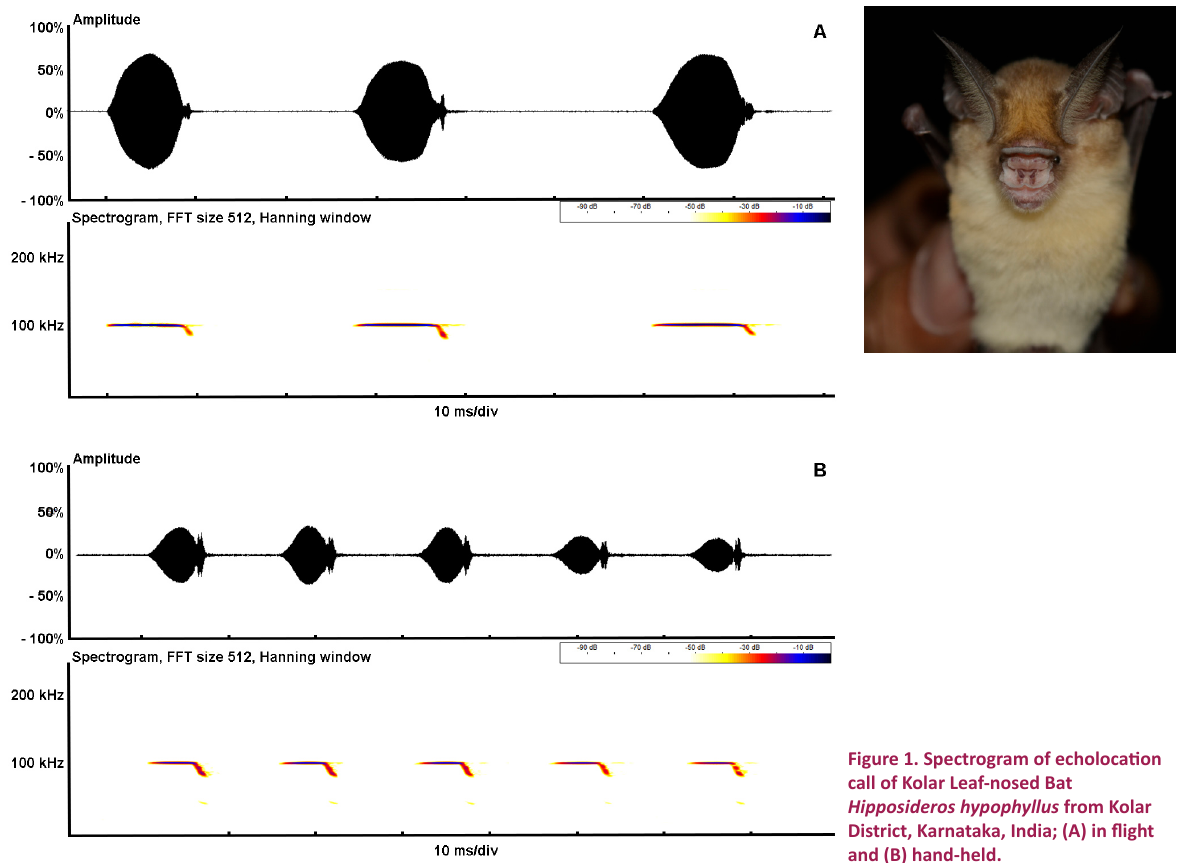
Figure 1. Spectrogram of echolocation call of Kolar Leaf-nosed Bat Hipposideros hypophyllus from Kolar District, Karnataka, India; (A) in flight and (B)